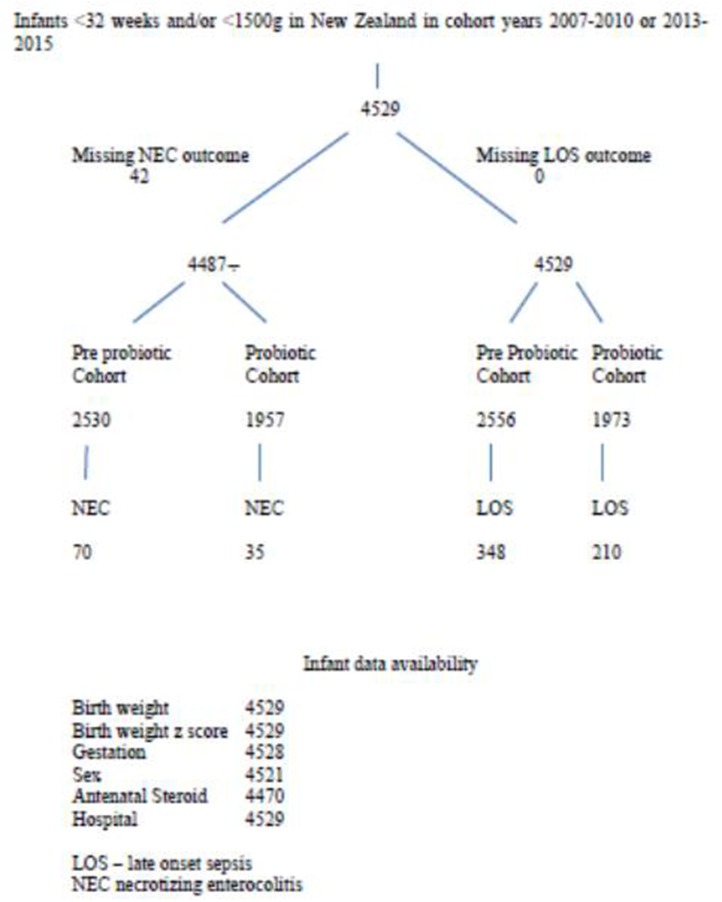
Flow diagram for necrotizing enterocolitis (NEC) and late onset sepsis (LOS).